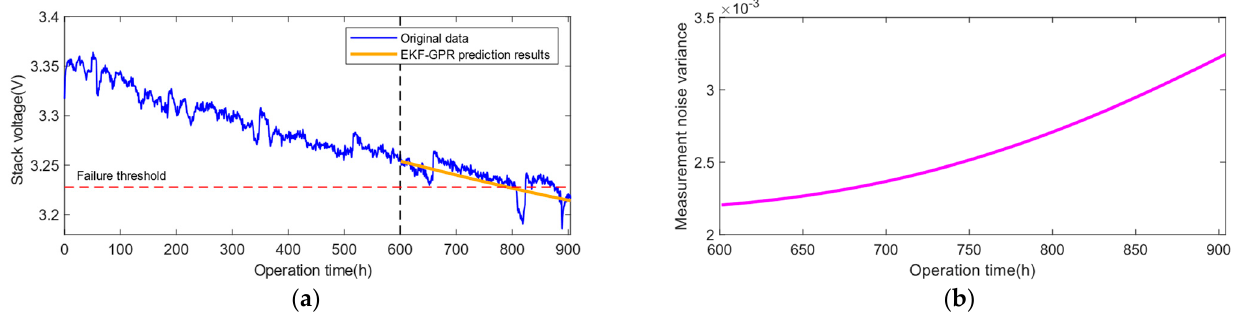
Figure 7. Prediction results of the EKF-GPR approach at the TP of 600 h: ( a )voltage prediction results and ( b ) measurement noise variance prediction results.